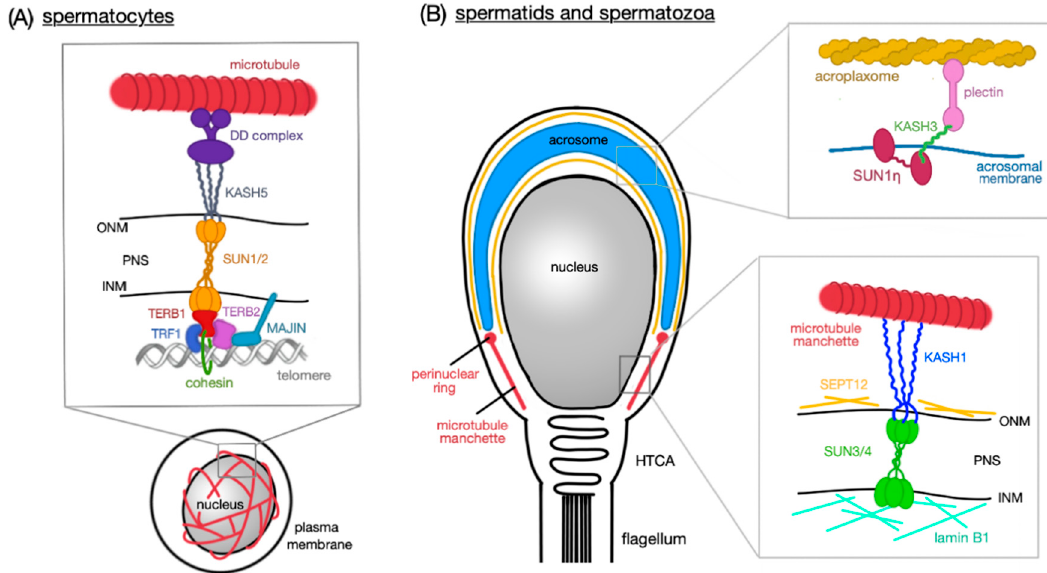
Figure 1. Schematic representation of LINC complex functions at different stages of sperm development. ( A ) Spermatocytes; heterotrimeric SUN1/2 forming a complex with KASH5 and enables chromosome movements during meiosis; KASH5 interacts with microtubules via dynein–dynactin (DD) complex. SUN1/2 is connected to TERB1, which recruits other nuclear proteins (TERB2, TRF1, and MAJIN) which have the capacity to bind to telomeric DNA repeats; TERB1 also binds to cohesin molecules thus stabilizing the connection between telomere and the LINC complex. ( B ) Spermatids (round and elongating—not shown) and mature spermatozoa; two distinct LINC complexes polarizes to the opposite poles of a sperm head; SUN1 ŋ :KASH3 complex is associated with the acrosomal membrane at the anterior pole where it mediates the connection with the acroplaxome via plectin molecules; SUN3/4:KASH1, on the other hand, polarizes to the posterior pole of the sperm head and associates with the microtubule manchette in the cytoplasm.